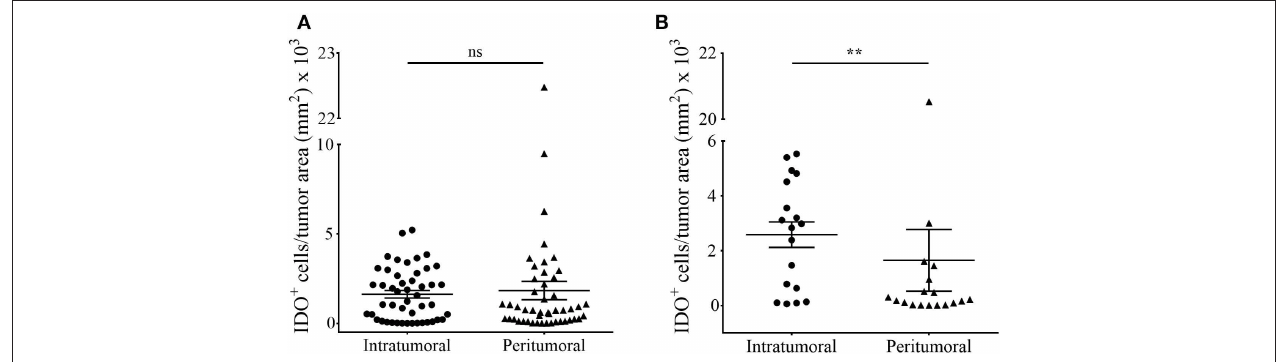
FIGURE 4 | Comparative analyses of intratumoral and peritumoral IDO-expression in human melanoma metastases of intracranial and extracranial origin. The total number of IDO-positive cells localized in the tumor (intratumoral) or around (peritumoral) in (A) ICM and (B) ECM was quantified in accordance to histopathological labeling of the tumor area by using the quantitative digital pathology tissue analysis system Definiens Tissue Studio ( n ICM = 48/47 patients, n ECM = 18/16 patient, n matched-pairs = 16; ** p < 0.05). To ensure statistical balance between both parameters we excluded all patient samples from the analyses in the case of missing stroma in the individual tissue specimen.